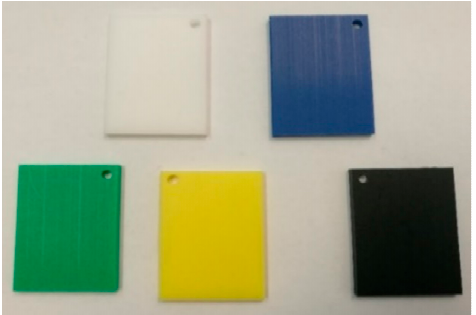
Figure 2. Five plastic samples with different inorganic pigments.